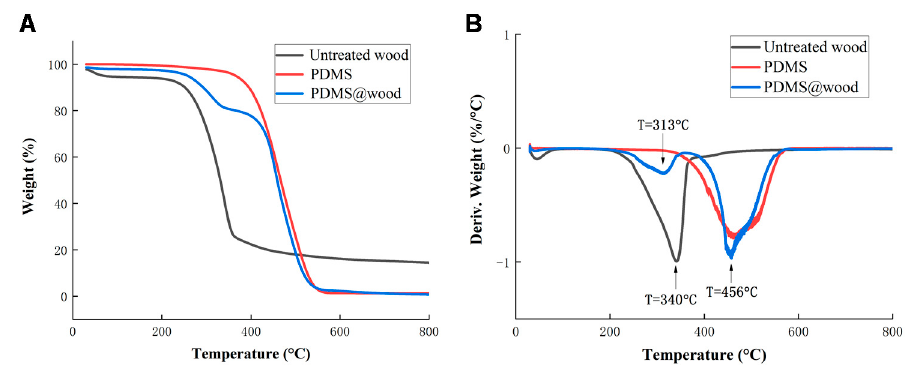
Figure 5. Thermogravimetric curves of untreated wood, PDMS, and PDMS@wood: ( A ) TG and ( B ) DTG.